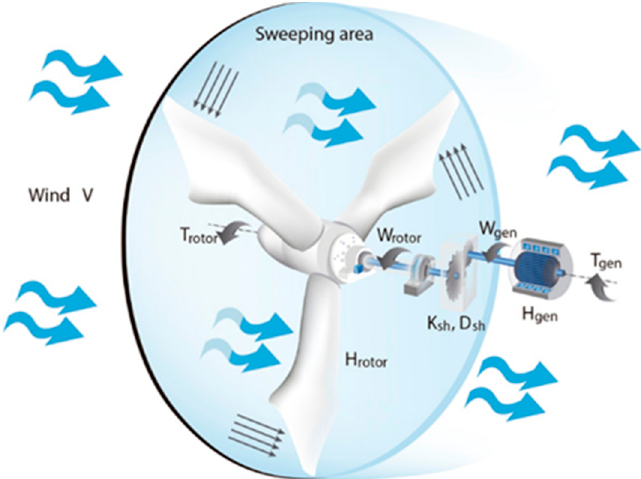
Figure 3. Schematic of the mathematical model of a wind turbine. All bodies exposed to an airflow experience an aerodynamic force that can be broken down into a pulling force in the wind direction and a lifting force perpendicular to the wind direction, which is the force that will cause the rotor to